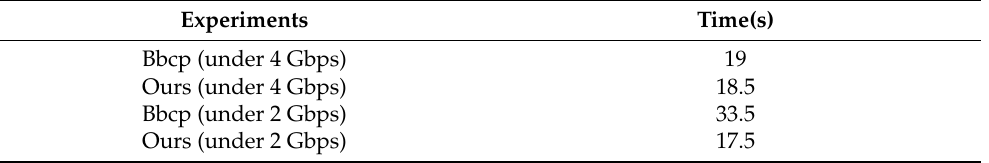
Table 1. Comparison of transfer time between Bbcp and our